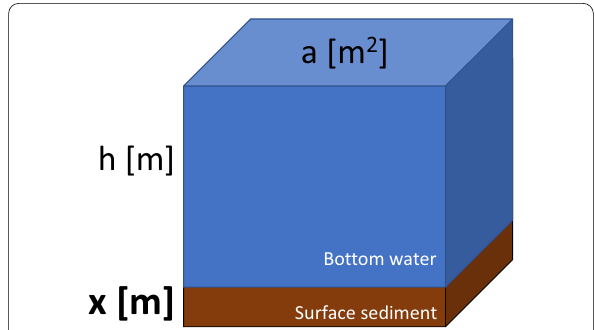
Fig. 7 Schematic simple box model in the bottom water and the surface sediment at the upper Sanriku slope. “x” is the thickness of surface sediments resuspended by the 2011 Tohoku Earthquake and aftershocks. “a” is the area at the upper Sanriku slope [m 2 ], and “h” is the thickness of bottom water affected by surface sediment resuspension due to the 2011 Tohoku Earthquake and